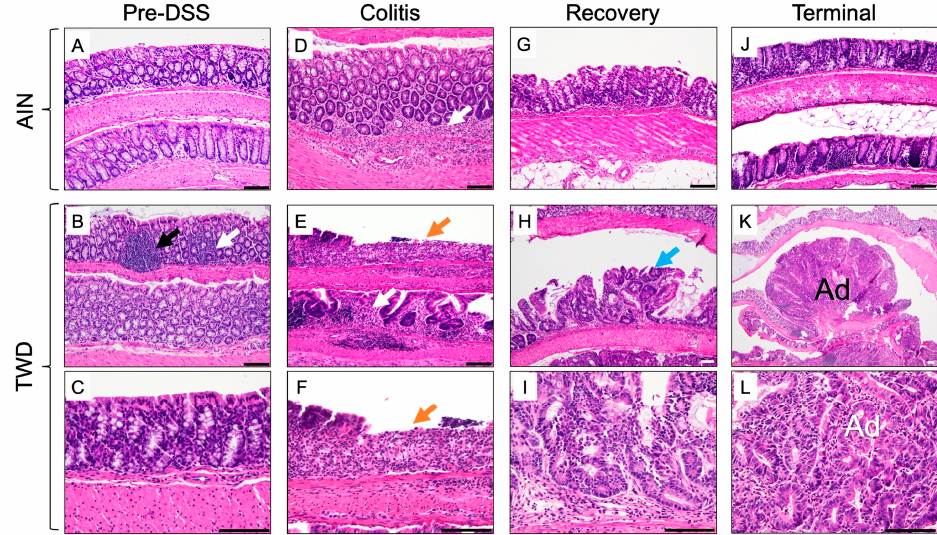
Figure 5. Histology of colonic tissues during the course of disease development. Representative images depicting H&E staining of colon tissues in mice fed AIN or TWD diets obtained prior to DSS treatment ( A–C ), during active colitis ( D–F ), during recovery from gut injury ( G–I ) and at the study end ( J–L ). Descriptions of tissue histology and image magnification: ( A ) normal colon (200 × ); ( B ) normal colon with occasional mild multifocal lymphocytic inflammation (white arrow) and gut-associated lymphoid tissue (black arrow) (200 × ); ( C ) normal colon (200 × ); ( D ) neutrophilic and lymphoplasmacytic colitis with inflammation in the mucosa and submucosa (white arrow) (400 × ); ( E,F ) neutrophilic and lymphoplasmacytic colitis with inflammation of the mucosa and submucosa (white arrow), mucosal ulceration (orange arrow), and loss of glands (E, 200 × ; F, 400 × ); ( G ) colon with mild lymphoplasmacytic and neutrophilic mucosal inflammation (200 × ); ( H,I ) Gastrointestinal intraepithelial neoplasia (blue arrow) (H, 100x; I, 400 × ); ( J ) normal colonic mucosa (200 × ); ( K ) colon adenoma ( A ) at low magnification (40 × ); and ( L ) colon adenoma (Ad) at high magnification (400 × ). Scale bar = 100 μ m.